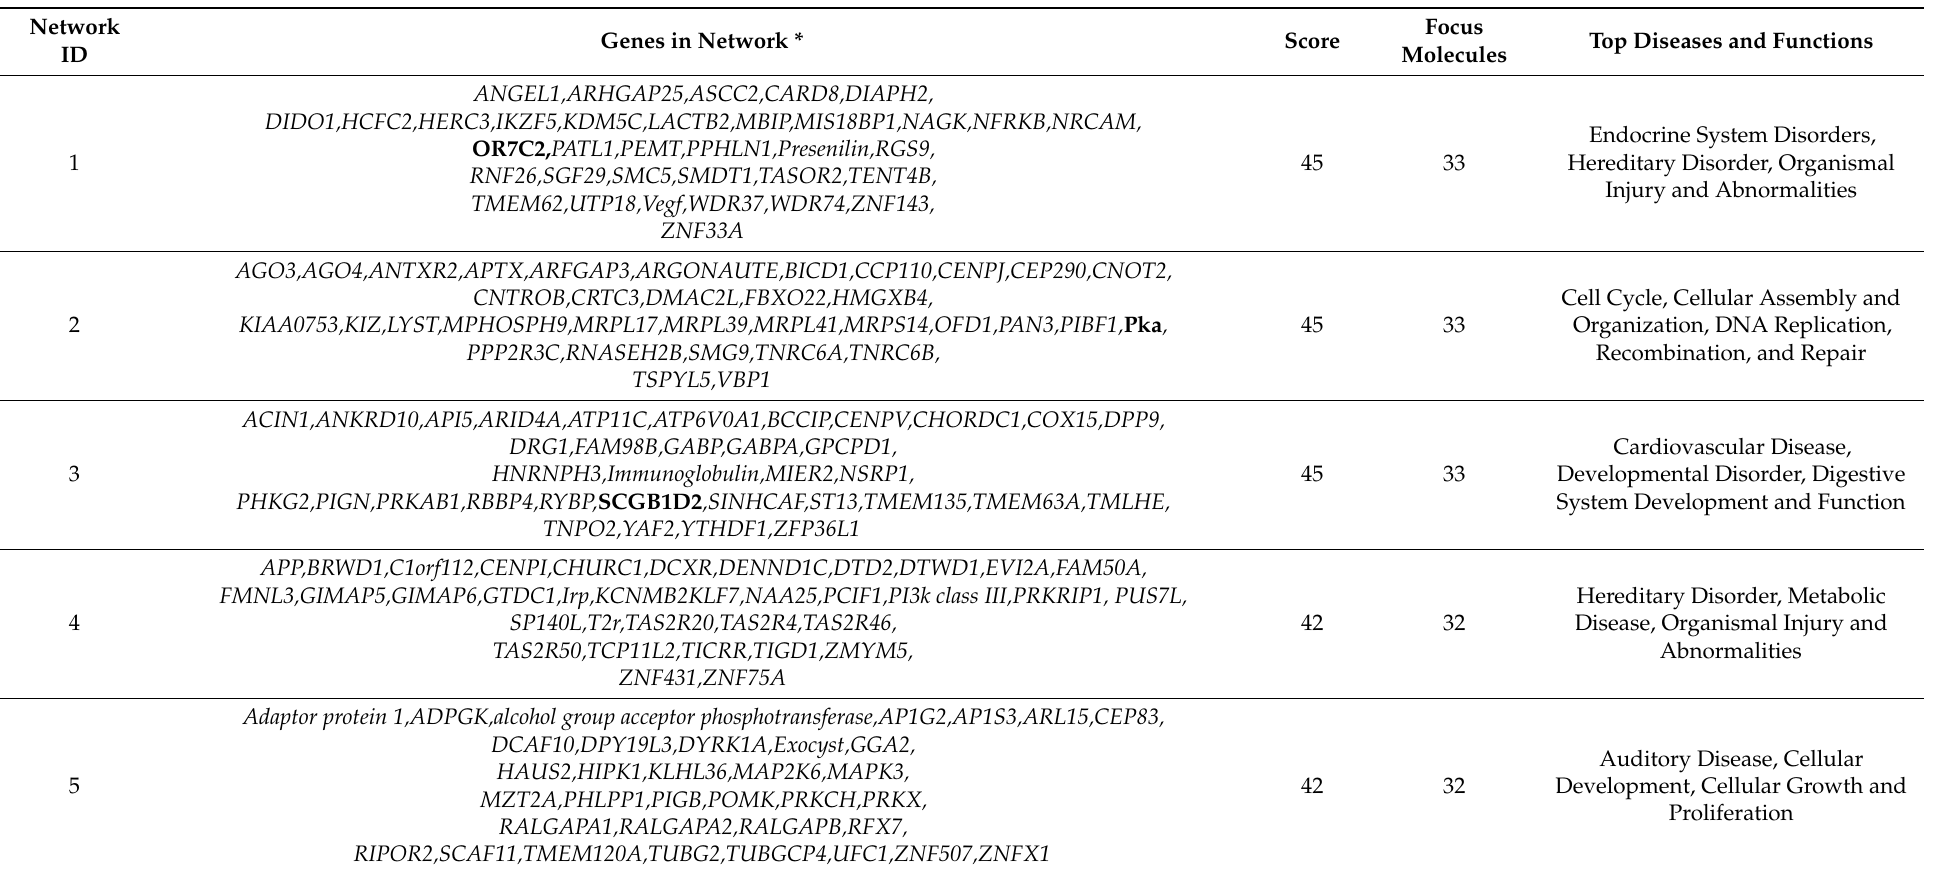
Table 8. Top five functional networks identified by IPA in lymphoblastoid cells and the associated differentially-regulated genes. See Supplementary Figures for depictions of additional IPA